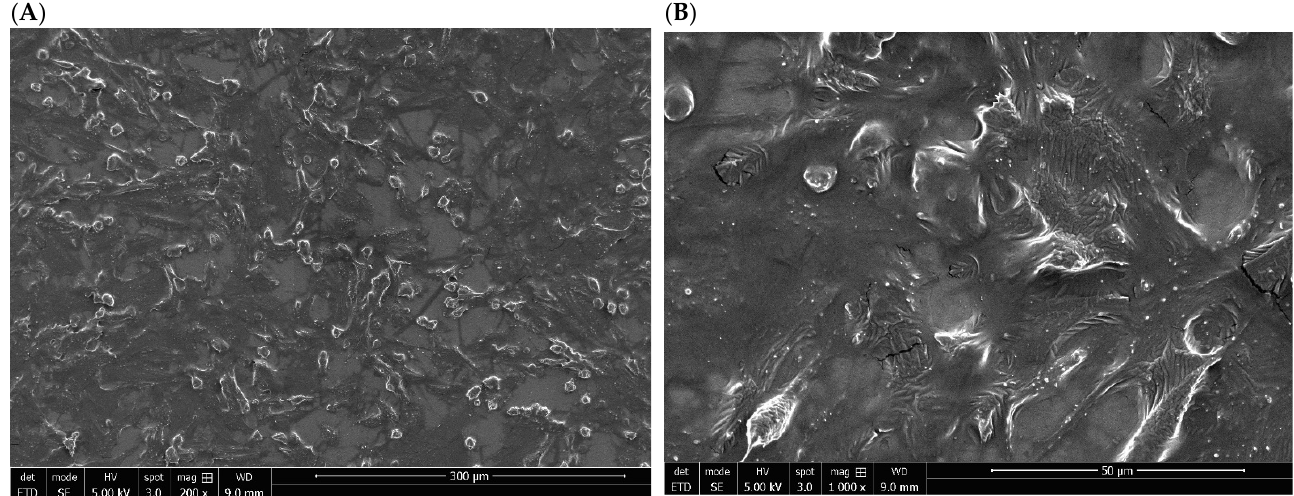
Figure 5. SEM image of SaOs-2 bone cells seeded on the surface of S_TiNb (mirror polished) disc at initial magnification of 300× ( A ) and 1000× ( B ) after a 72-h incubation period.